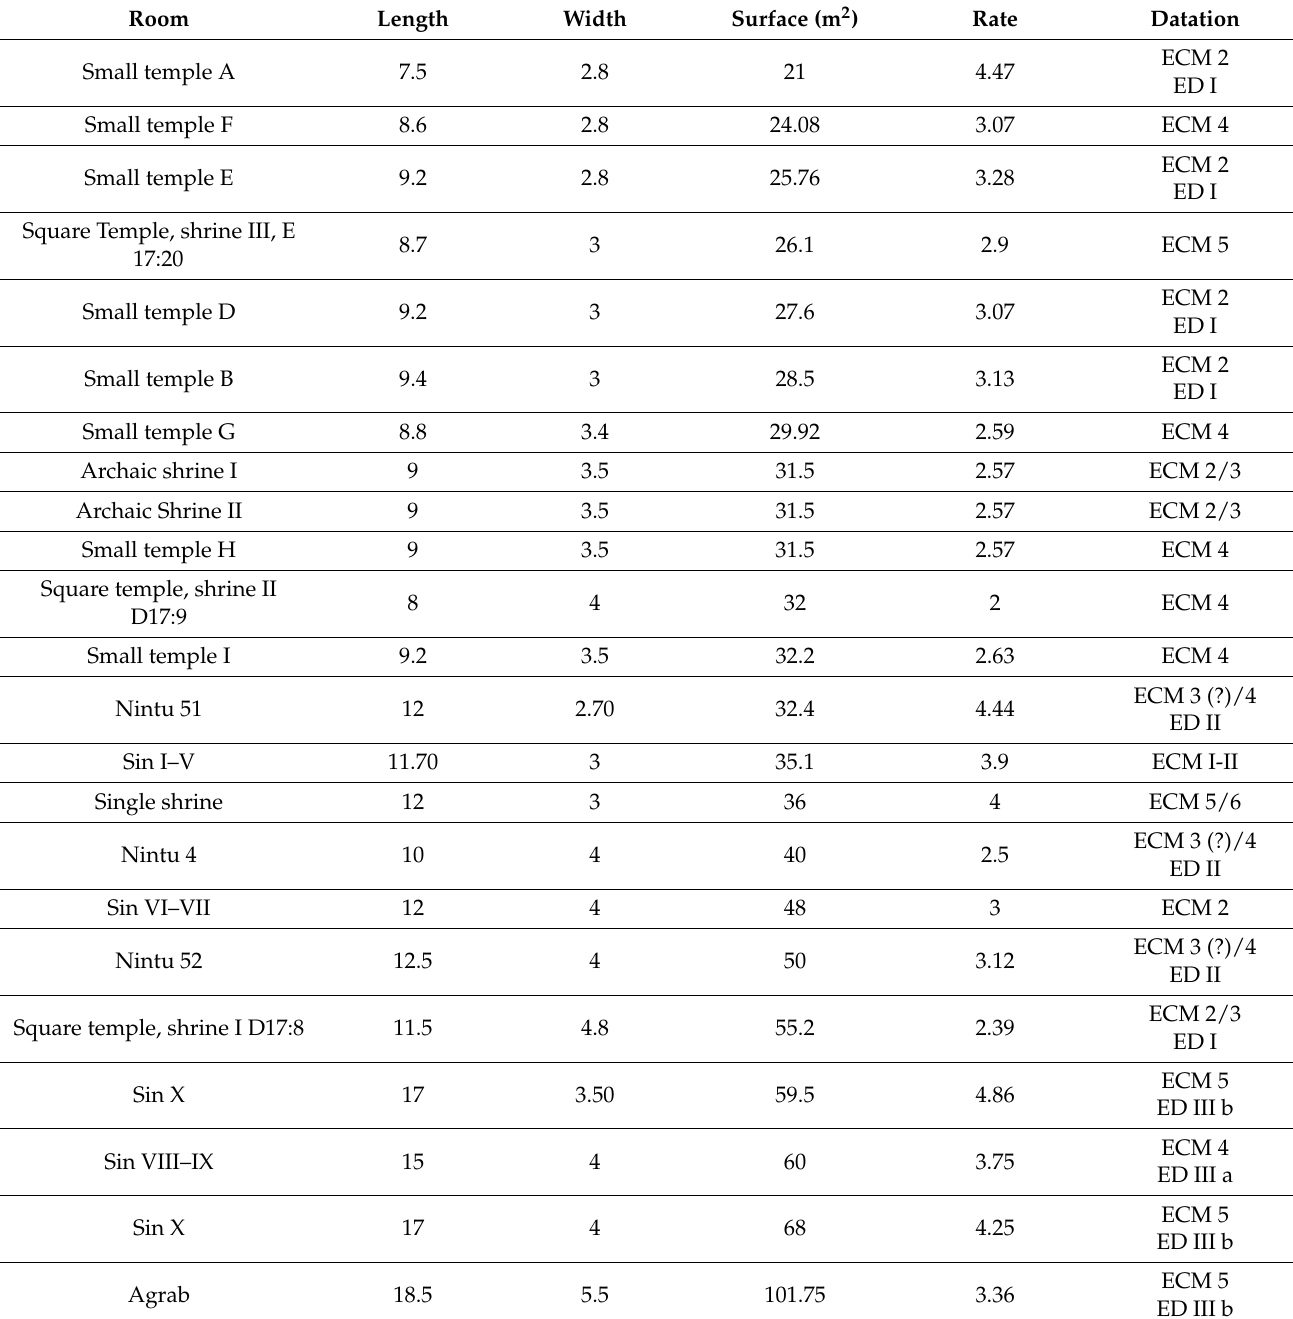
Table 2. Diyala Early Dynastic temples, ceremonial rooms, length, and width, ordered by